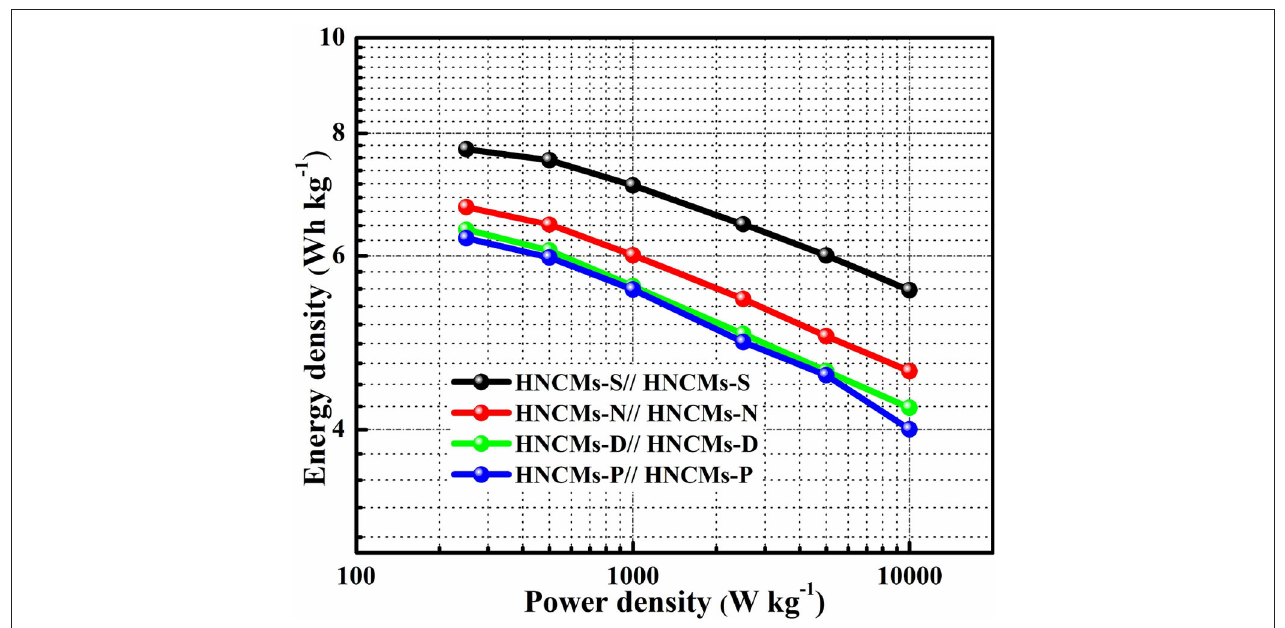
FIGURE 7 | Ragone plots of HNCMs-X//HNCMs-X